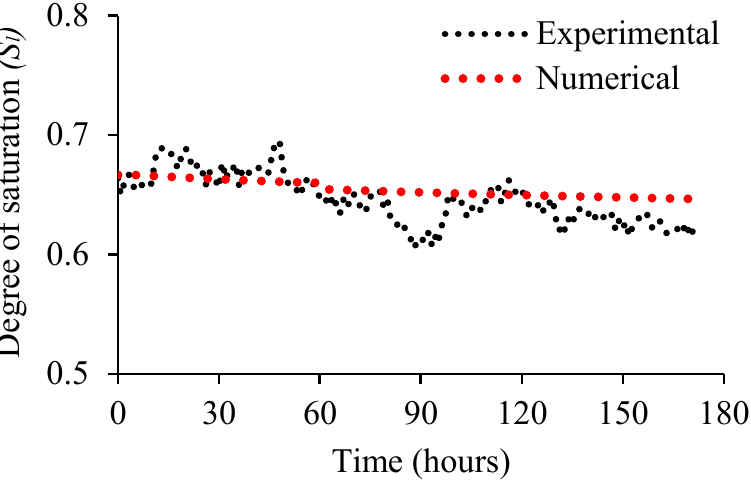
Figure 8. A comparison of the results of the experimental and numerical investigations for the unsaturated sand.